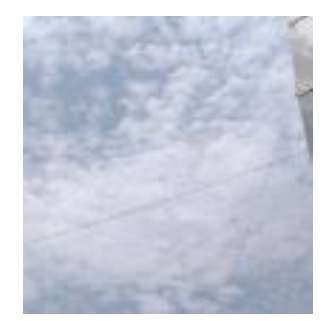
Figure 15: Cloudy sky with Turbidity 5.27